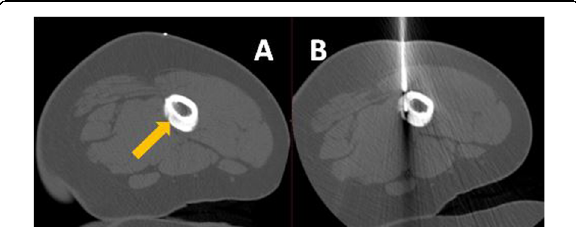
Fig. 16 Radiofrequency ablation. Axial section of right femur shows a the nidus with a thickened cortex. b RF electrode tip noted within the lesion